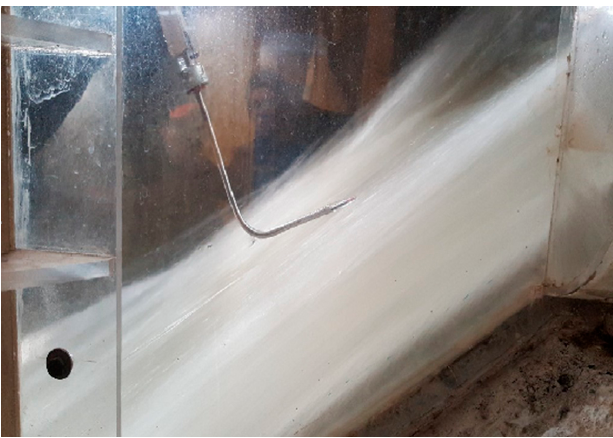
Figure 4. Double-tip conductivity probe.